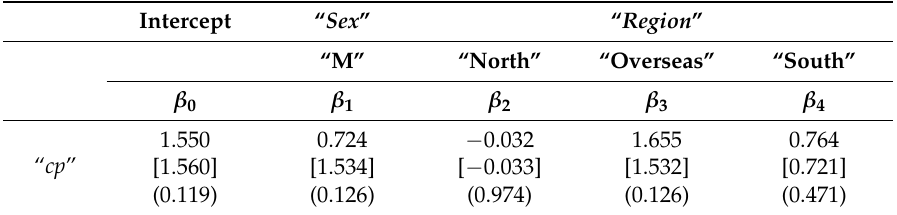
Table A5. Estimation results of “ cp ” against “ Region ” and “ Sex ”.